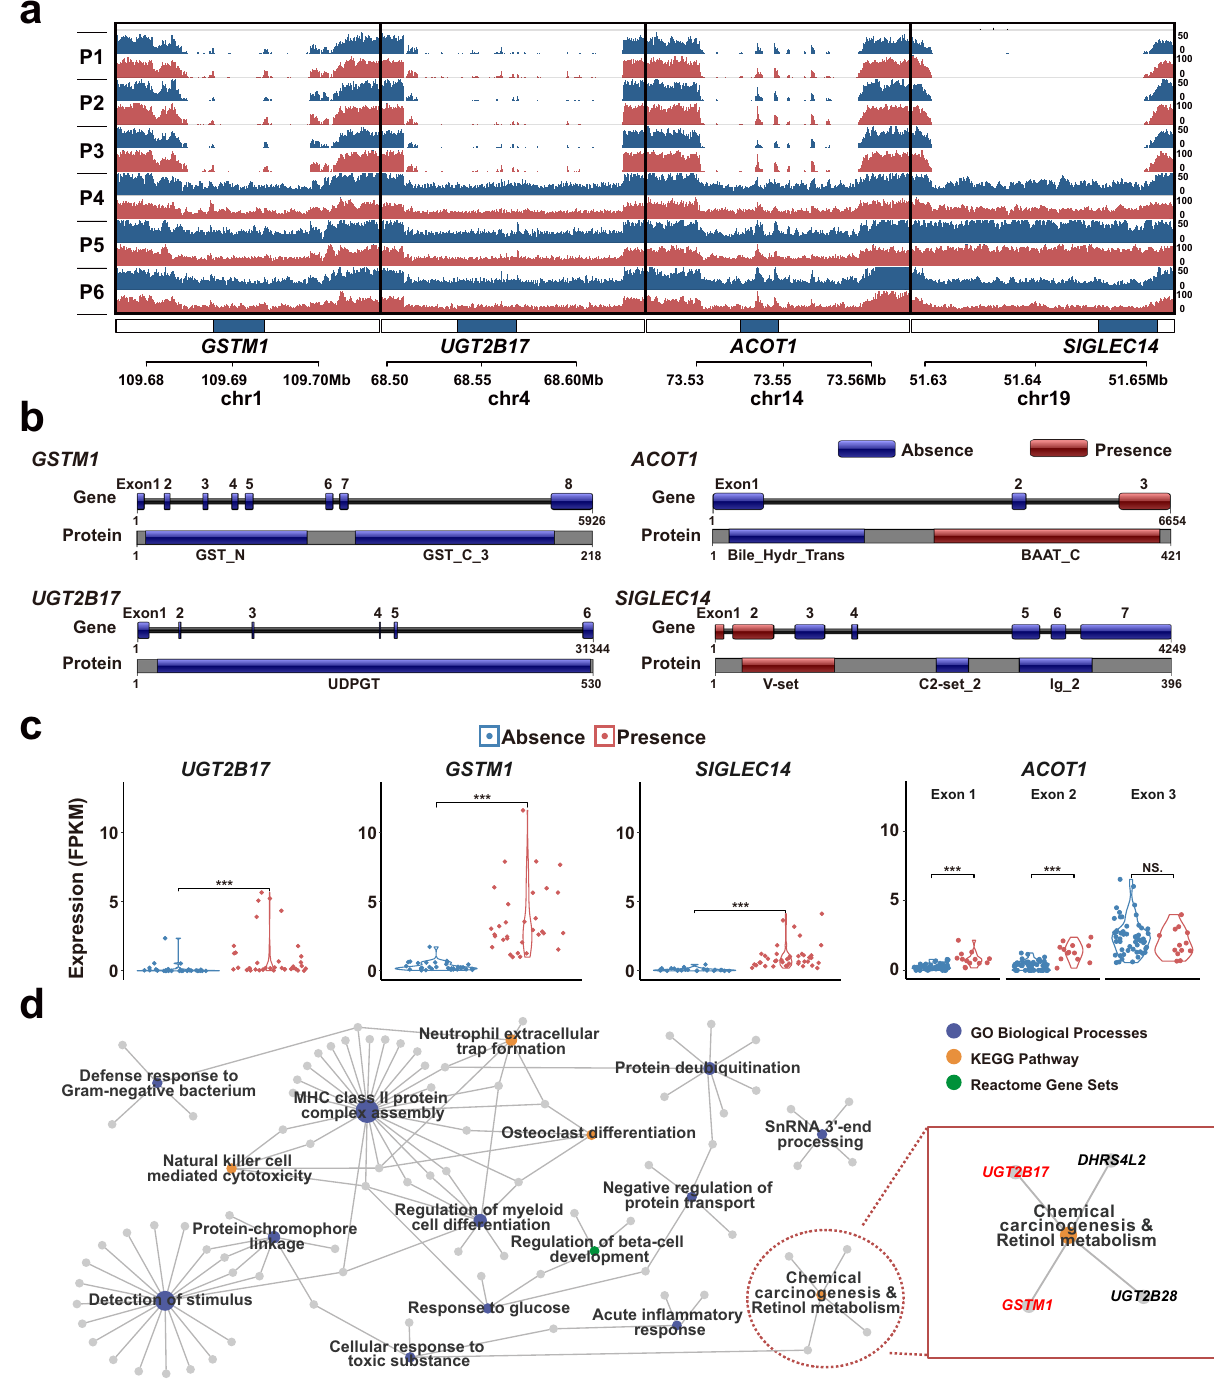
Fig. 3 | The paradigms of absence variation and functional enrichment of dis- otributedgenes.a Theabsentcoverageoncorrespondingchromosomallocations of GSTM1 , UGT2B17 , ACOT1 , and SIGLEC14 in three representative absence (P1 – P3) and three presence (P4 – P6) cancer samples. The tracks of blue and red stand for normal mucosa and cancer tissue, respectively. b The sketches of gene structures and conserved domains of protein-encoding sequences in InterPro database. The